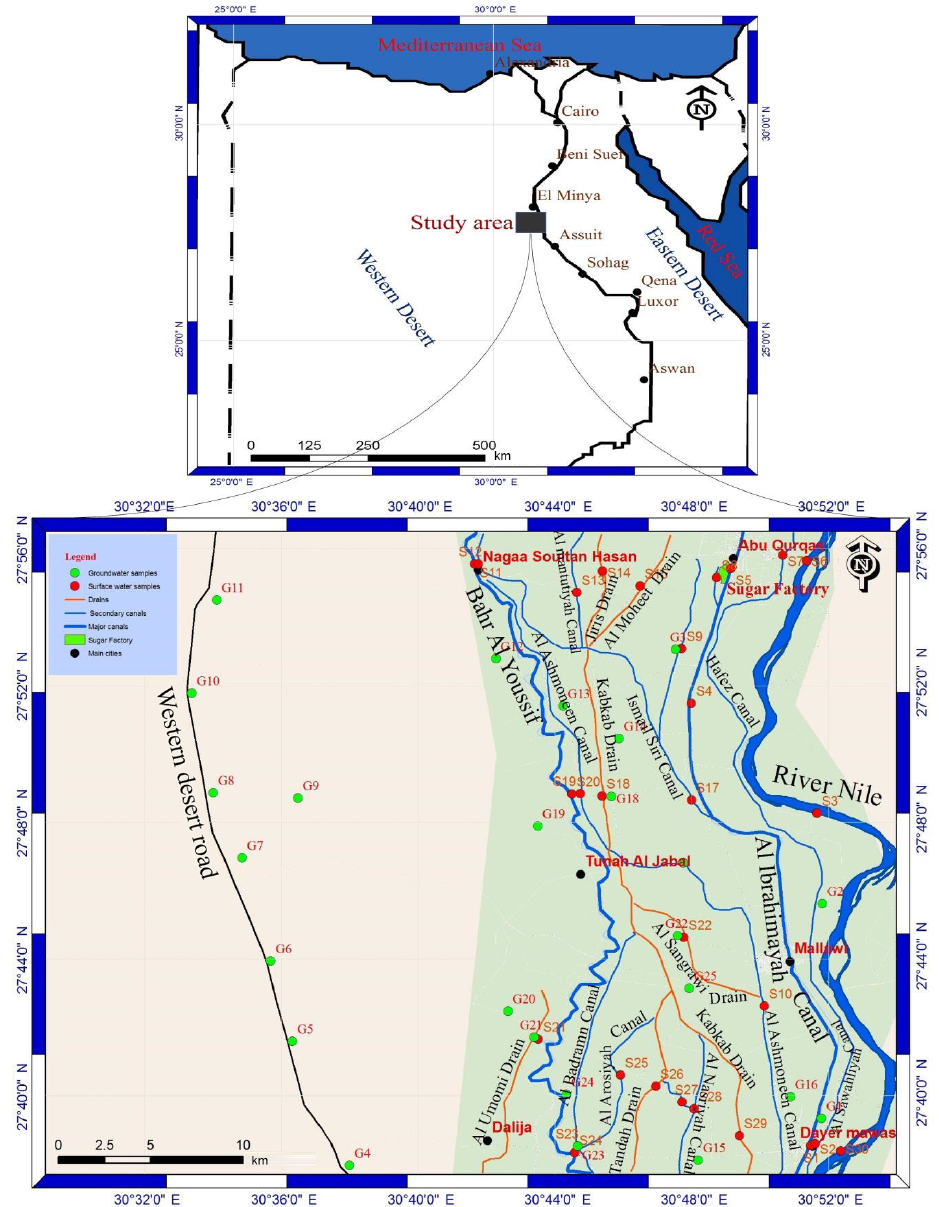
Figure 1. Location map of the study